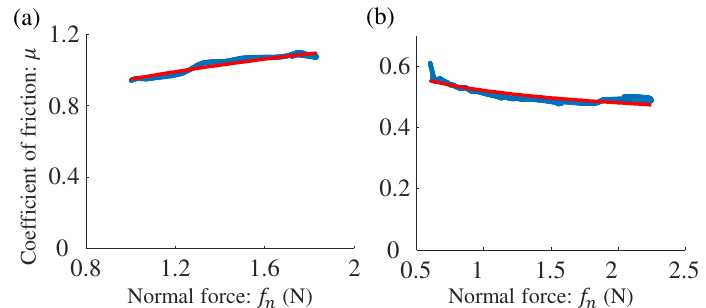
Figure 3. Data plots and fitting results of the relationship between µ and f n . Red curves represent the fitting curves, and the blue dots correspond to the observed coefficients of friction. ( a ) β is positive ( β = 0.24). ( b ) β is negative ( β = −